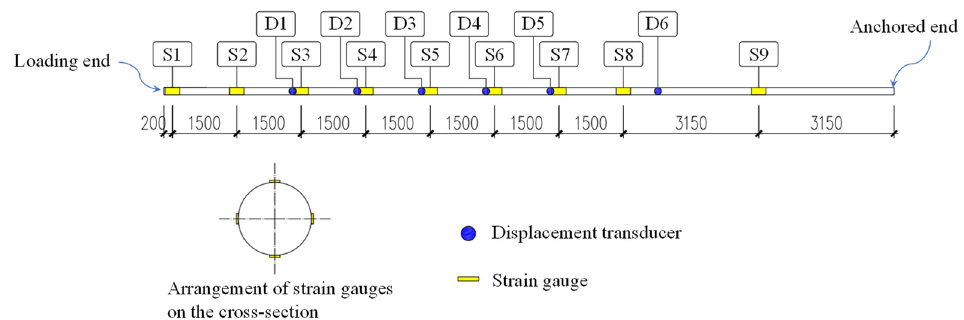
Figure 20. Arrangement of strain gauges and displacement transducers.